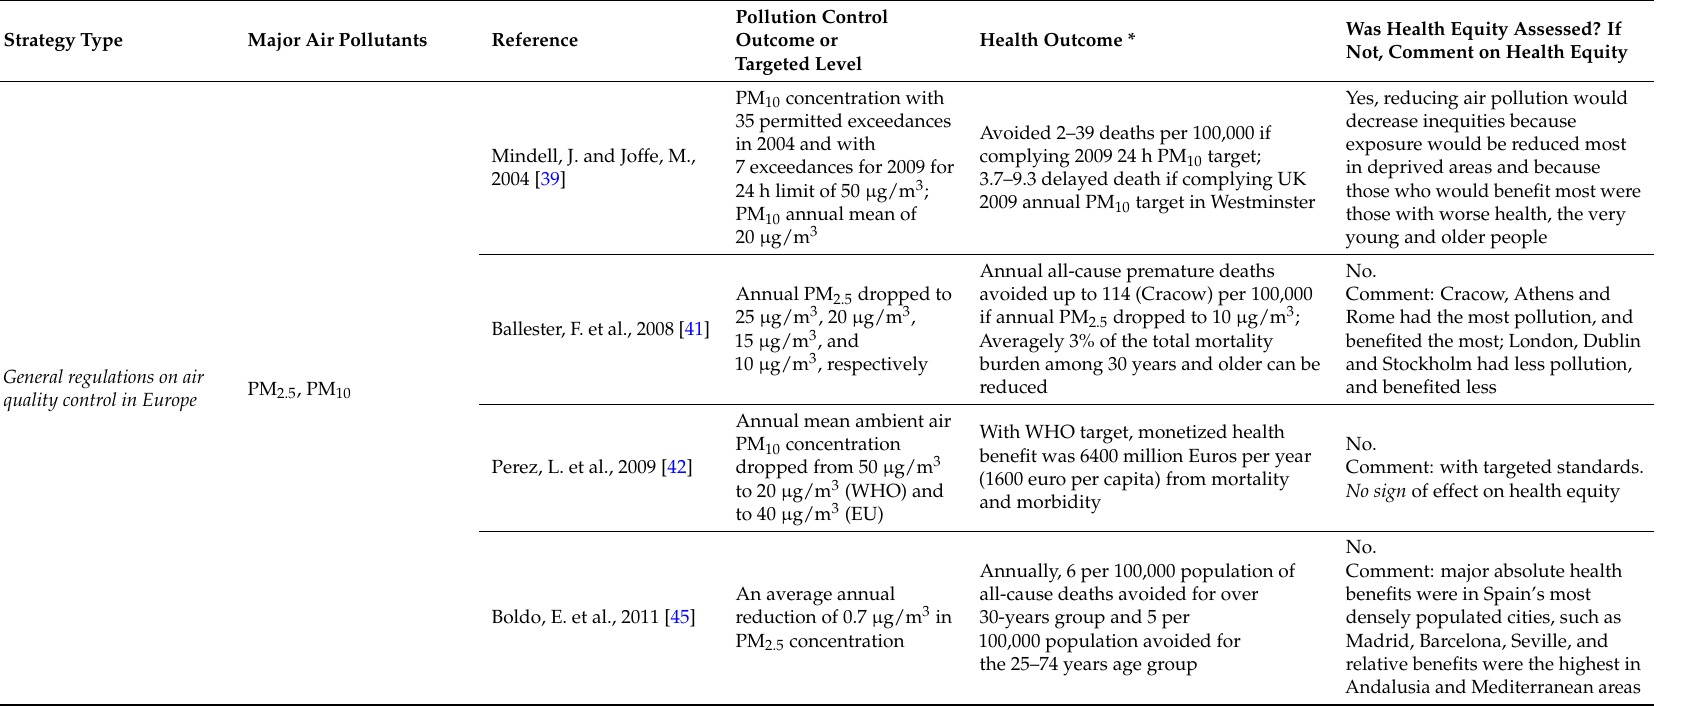
Table 3. Summary of health impact assessments and comments on health equity according to the type of the